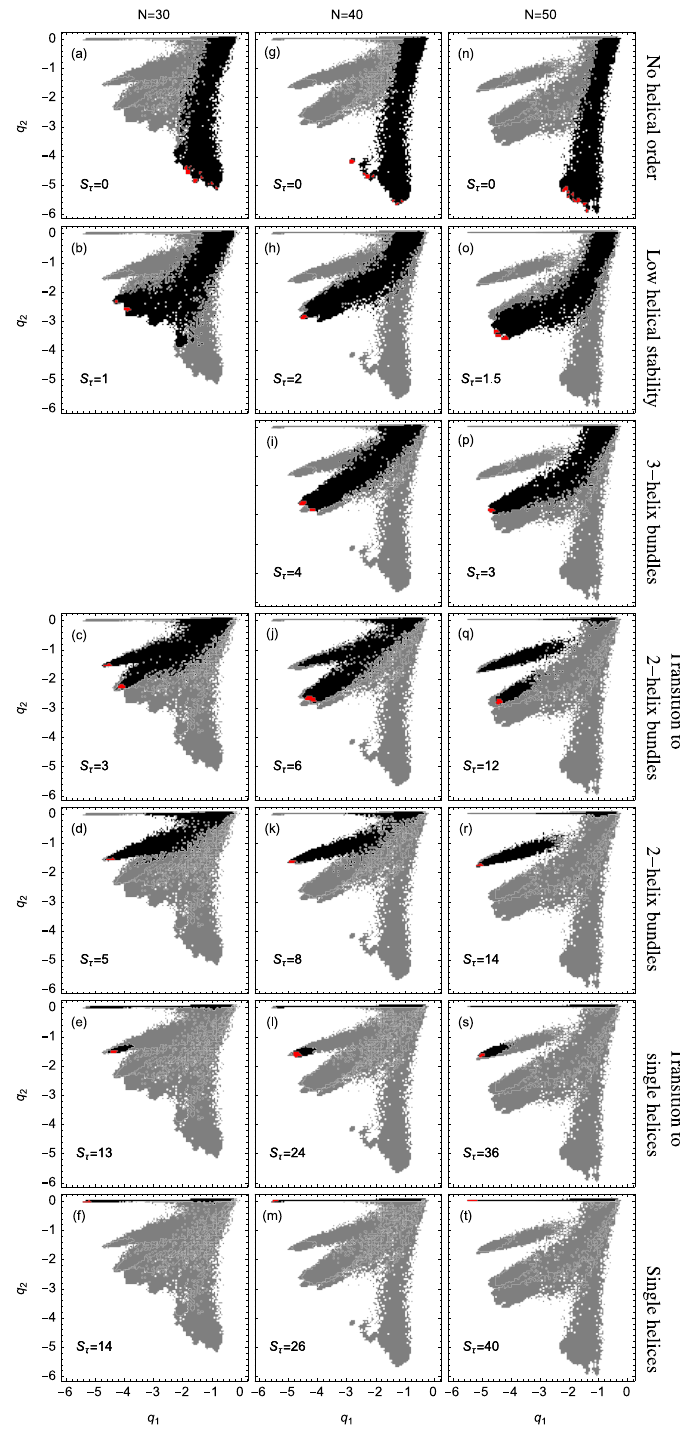
Figure 5. Distribution of polymer conformations in q 1 − q 2 space for an array of values for S τ and N . Gray regions cover all structures obtained in simulations of a single polymer length N across all values of S τ and temperatures. Black regions highlight the part of the distribution that dominates for the specified S τ value, and red regions represent only the lowest-temperature structures. Chosen S τ values correspond to specific structure types. For ordered helix-bundle geometries, intermediate S τ values fall into the discrete structure types